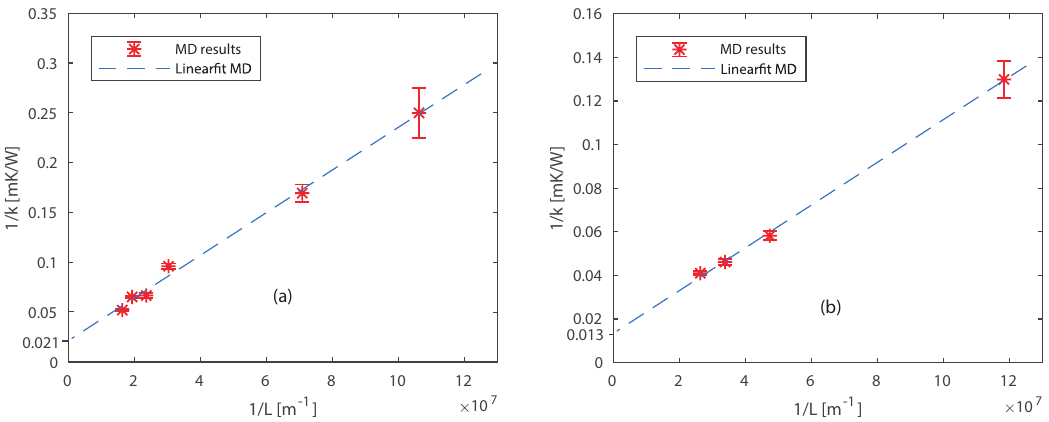
Figure 5. Extrapolation of thermal conductivities for different sizes of ( a ) Pt and ( b )